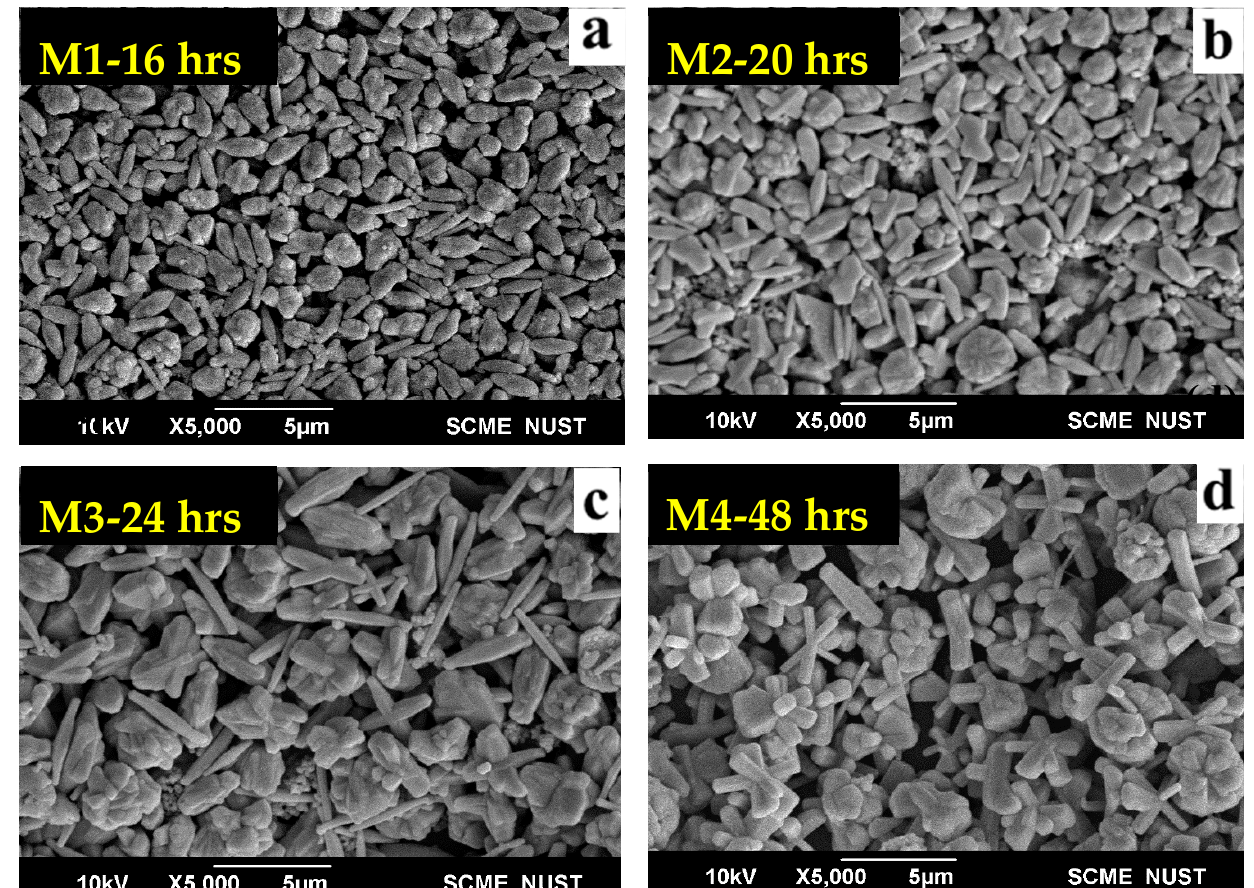
Figure 3. SEM micrographs of the SnSe 2 thin films drop casted on a glass substrate. The variation in morphologies with increased reaction time can easily be seen. M1 represent the sample with reaction time of 16 h ( a ), M2, 20 h ( b ), M3 reaction time was 20 h ( c ) and M4 reaction time was 48 h as shown in Figure 3 (d).